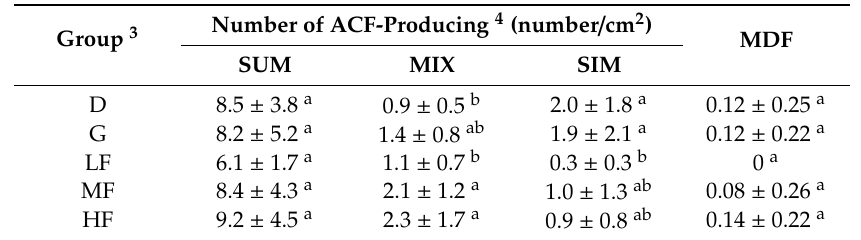
Table 2. Effects of GBR and FGBR on the numbers of DMH/DSS-induced ACF according to the type of mucin and MDF in the distal colon of F344 rats 1,2 .